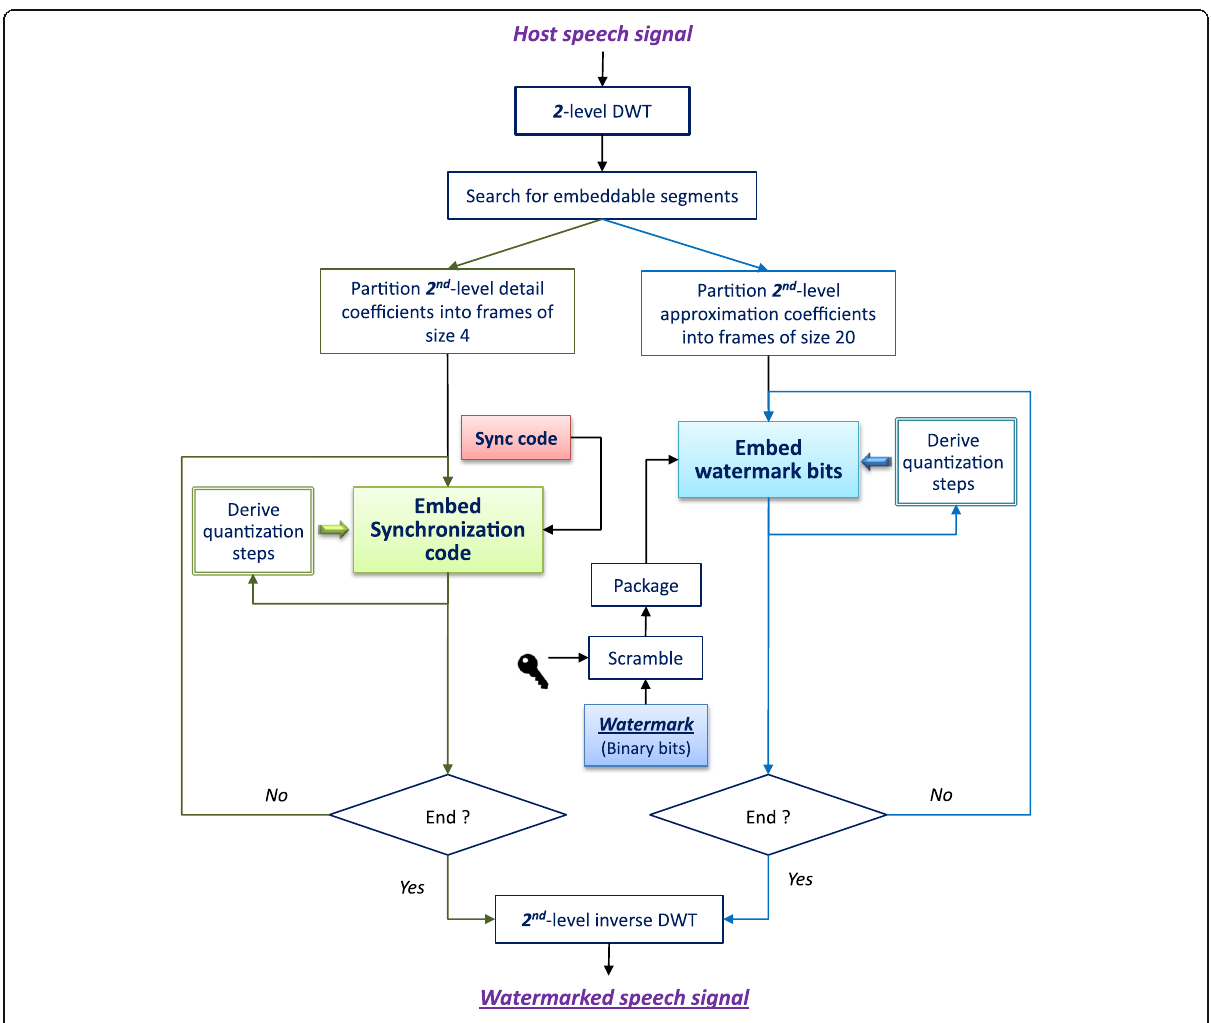
Fig. 4 Embedding procedure of the proposed DWT-AMM watermarking